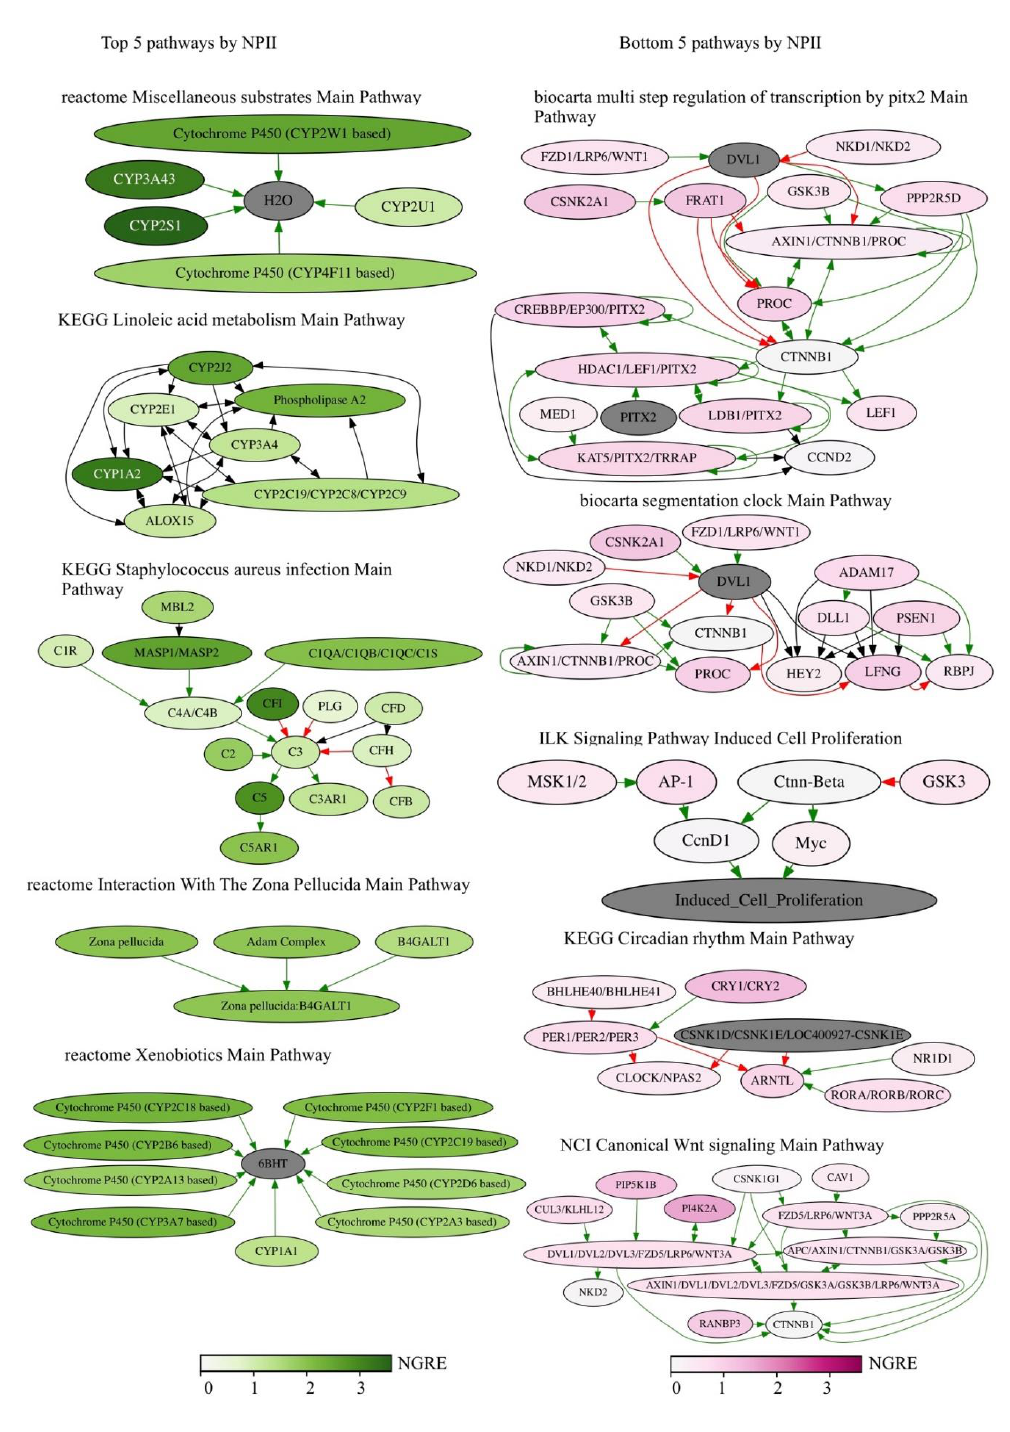
Figure 6. Top five RRE-enriched and deficient pathways sorted by NPII for all REs.